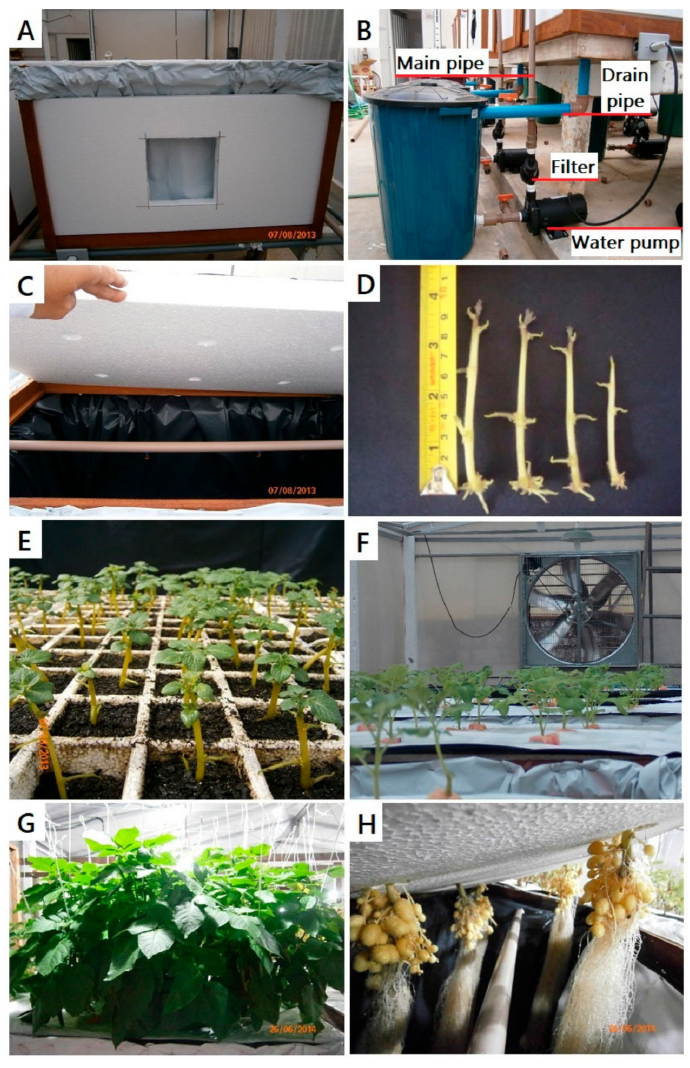
Figure 2. Wood box ( A ); connection to a nutrient solution bucket, electric water pump, filter, and main pipe that irrigate plants in the box, and a drain pipe that recycles the nutrient solution ( B ); holes in the upper Styrofoam box lid ( C ); ( D ) virus-free sprouts from pre-nuclear seed-potato plants that were positioned through the holes pictured in ( C ) to originate plants as a source of potato seeds; Rooting of sprouts ( E ); growth of potato plants ( F ); potato plant tutoring with twine string ( G ); seed-potato minitubers ( H